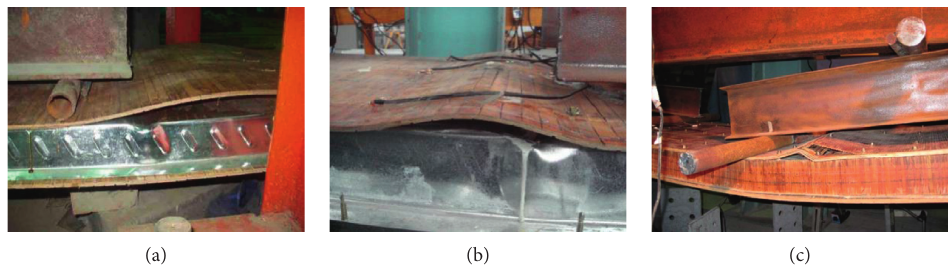
Figure 8: Failure mode of composite slabs. (a) Failure mode of PBS. (b) Failure mode of CBS. (c) Failure mode of